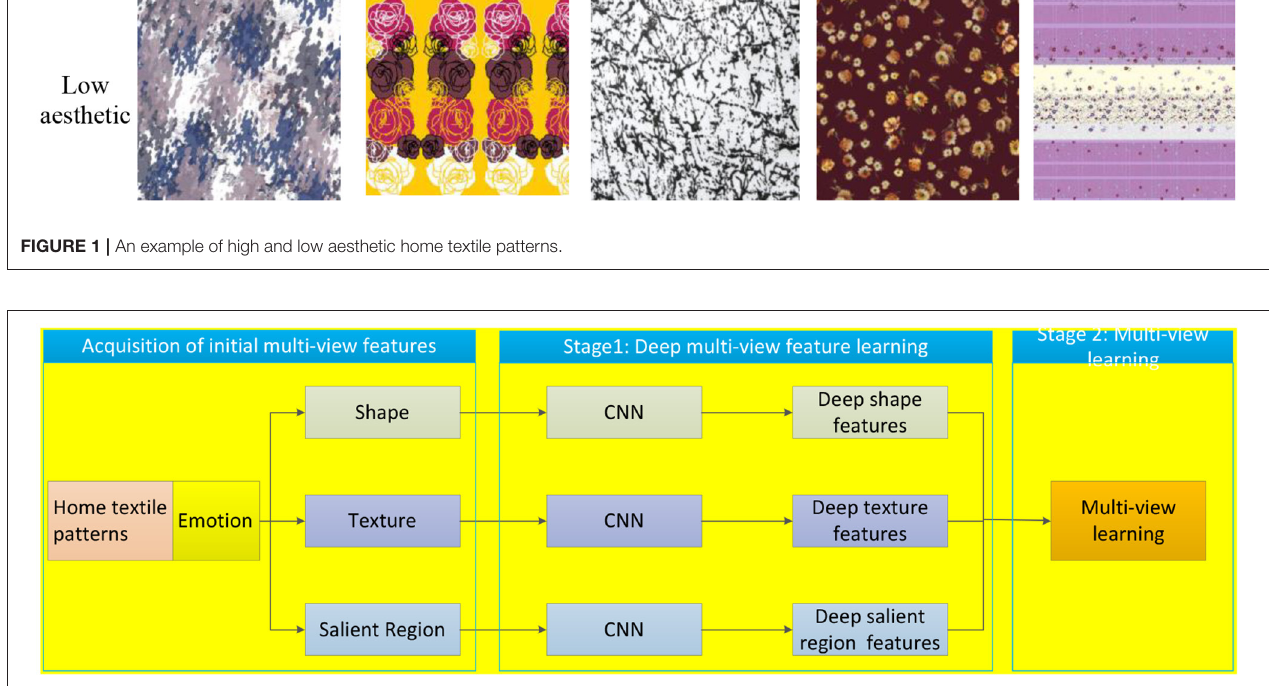
FIGURE 2 | Three-stage framework of emotion